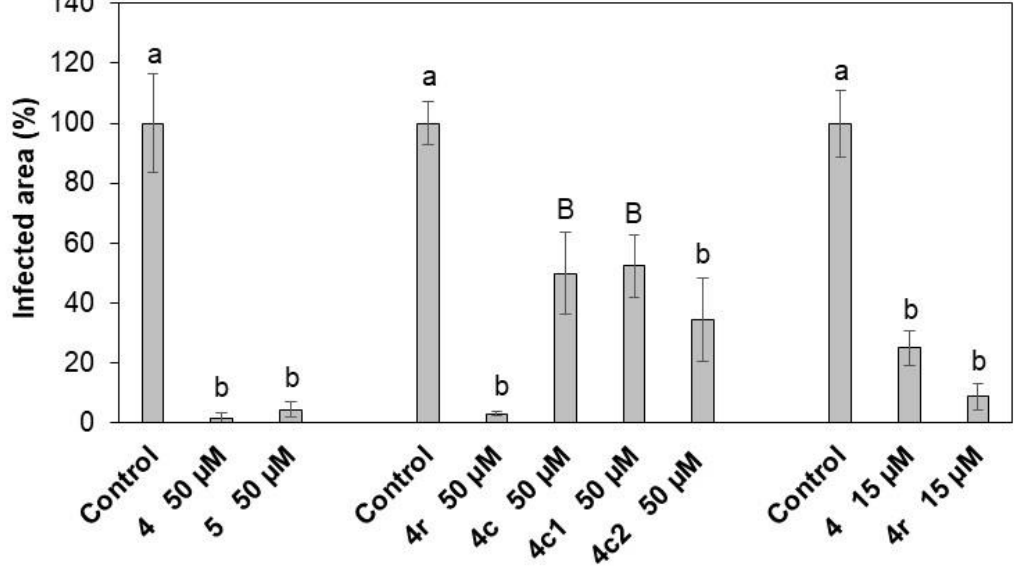
Figure 4. Symptomatic area of common bean leaves treated with 4 , 4r , and 5 , and the shorter analogs 4c , 4c1 , and 4c2 at 50 or 15 µM and inoculated with B. cinerea conidia. Each treatment was compared to the respective control. The symptomatic leaf area was measured 7 days post-inoculation (dpi) and is expressed as a percentage compared to the control (treated with water). Bars indicate standard error. At least three independent infection sessions were performed. Data were statistically analyzed by one-way Anova Bonferroni–Holm. Different letters indicate significant differences at p < 0.01 (lowercase letters) or p < 0.05 (uppercase letters).